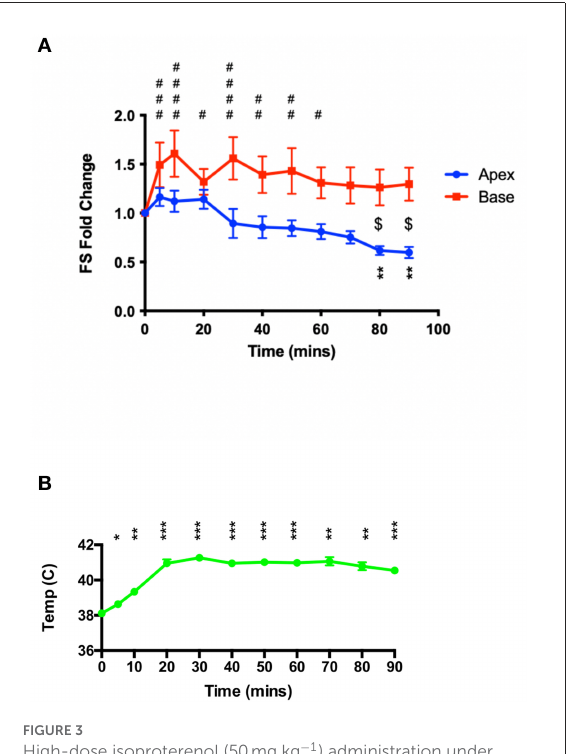
FIGURE3 High-dose isoproterenol (50mg.kg − 1 ) administration under hyperthermic conditions ( ∼ 41 ◦ C) results in apical-hypocontractility. (A) 50mg.kg − 1 isoprenaline under ketamine-midazolam anesthesia resulted a significant positive inotropic response was seen in the basal myocardial segment for the first 60min, whereas the apical myocardial segment showed a significant negative inotropic response at 80 and 90min post-isoprenaline. ** P < 0.01 apex vs. baseline; $ P < 0.05 apex vs. base; # P < 0.05, ## P < 0.01, ### P < 0.001, #### P < 0.0001 base vs. baseline, two-way repeated measures ANOVA ( n = 6). (B) Sustained heating of the animal maintains a significant elevated body temperature post-isoproterenol. * P < 0.05, ** P < 0.01, *** P < 0.001 relative to baseline temperature, one-way ANOVA ( n = 6